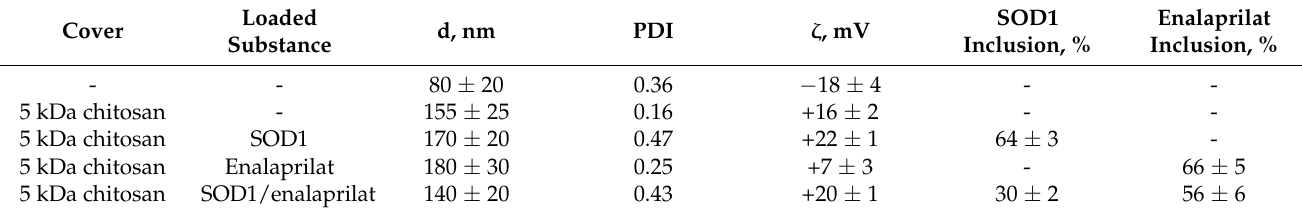
Table 1. Characteristics of obtained nanoparticles.